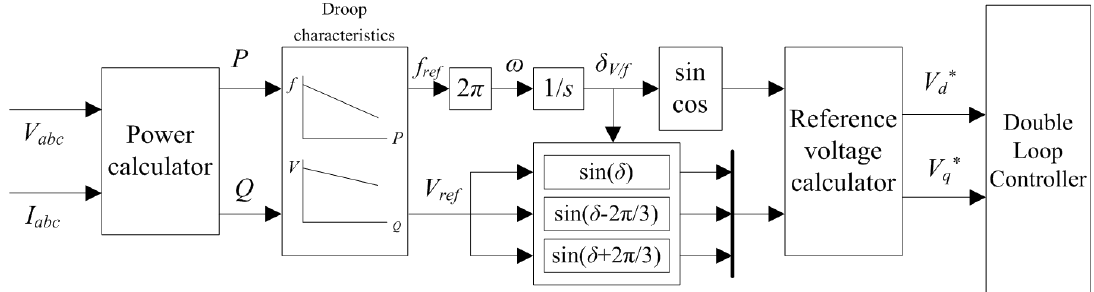
Figure 13. Diagram of the V/f controller based on dq rotating coordinate synchronization.